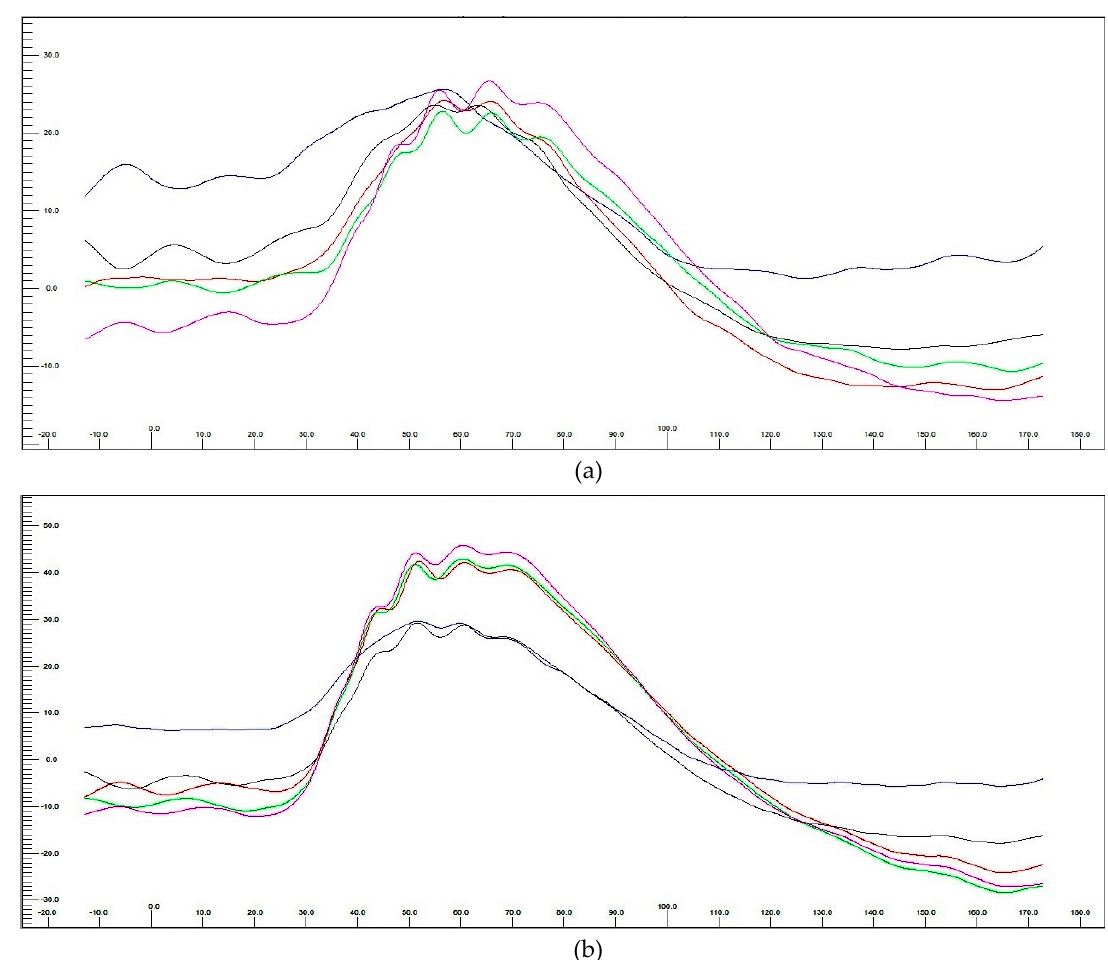
Figure 10. Representative electroretinography traces presenting dark adaptation before ( a ) and after ( b ) MV injection. There is a significant difference in the amplitude changes during the dark adaptation. Each color-marked trace represents a time-delayed recording made during 20 min of ERG examination consisting of 5 measurements every 4 minutes.